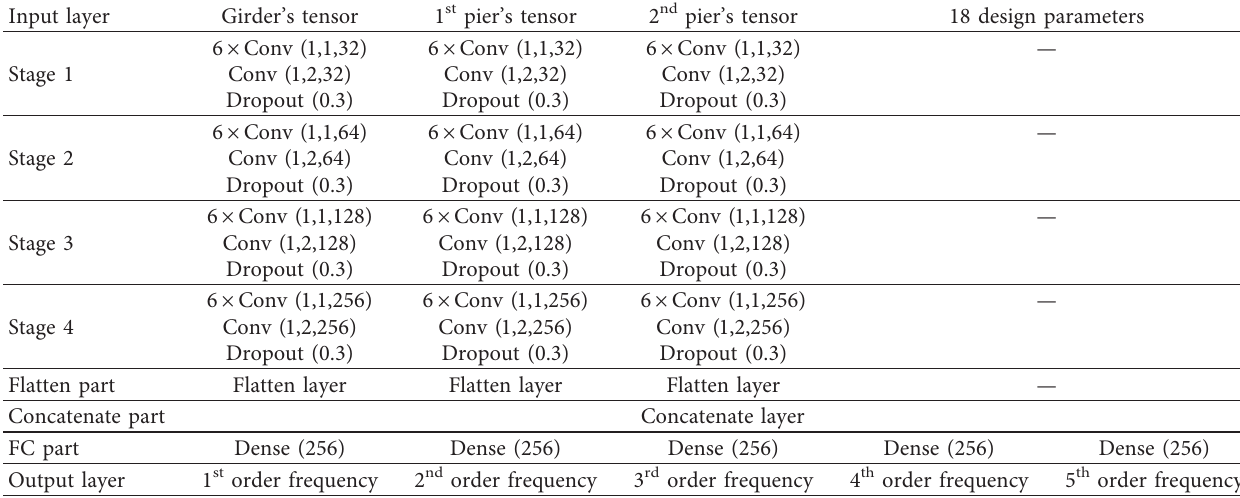
Table 2: 3D-CNN configuration.